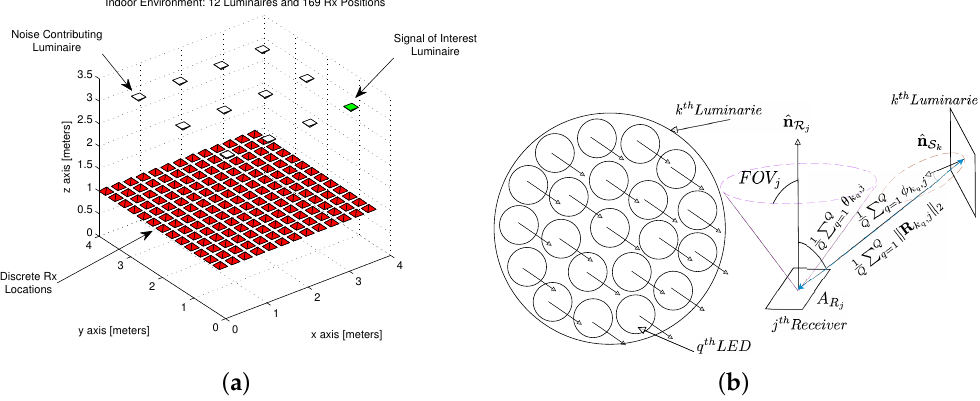
Figure 1. Model Description: ( a ) Indoor Environment Model with 12 Source Luminaries and 169 Discrete Receiver Positions in a 4 m by 4 m by 3.5 m room without Obstructions; and ( b ) iVisible Light Channel Geometry Model for the k th source Luminaire with Q LED’s Transmitting Modulated Data to the j th Receiver in an Indoor